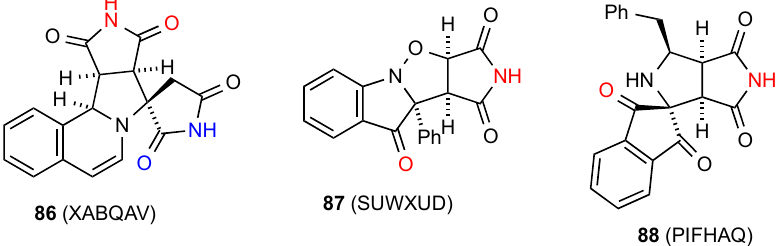
Figure 30. Five-membered ring fused succinimides showing patterns H and D.